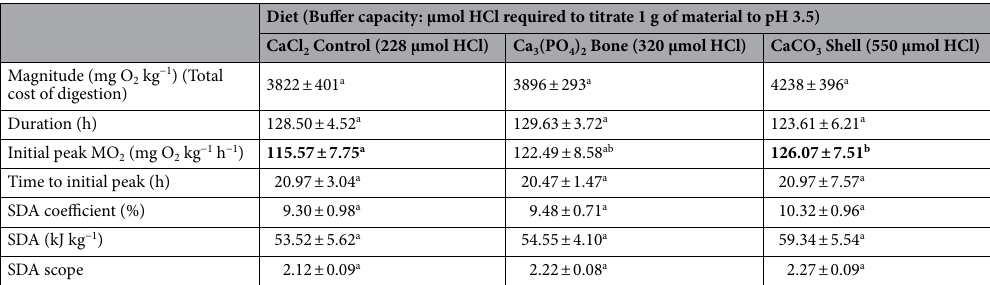
Table 1. Summary of SDA responses in juvenile rainbow trout ( Oncorhynchus mykiss ) fed a 2.5% ration of a diet supplemented with either CaCl 2 , Ca 3 (PO 4 ) 2 or CaCO 3 (n = 8 animals each consuming all three diets). Lowercase letters and bold text indicate significant differences between diets at P < 0.05 following a repeated measures one-way ANOVA (RM- ANOVA) and Tukey multiple comparisons test. Data are presented as mean ±